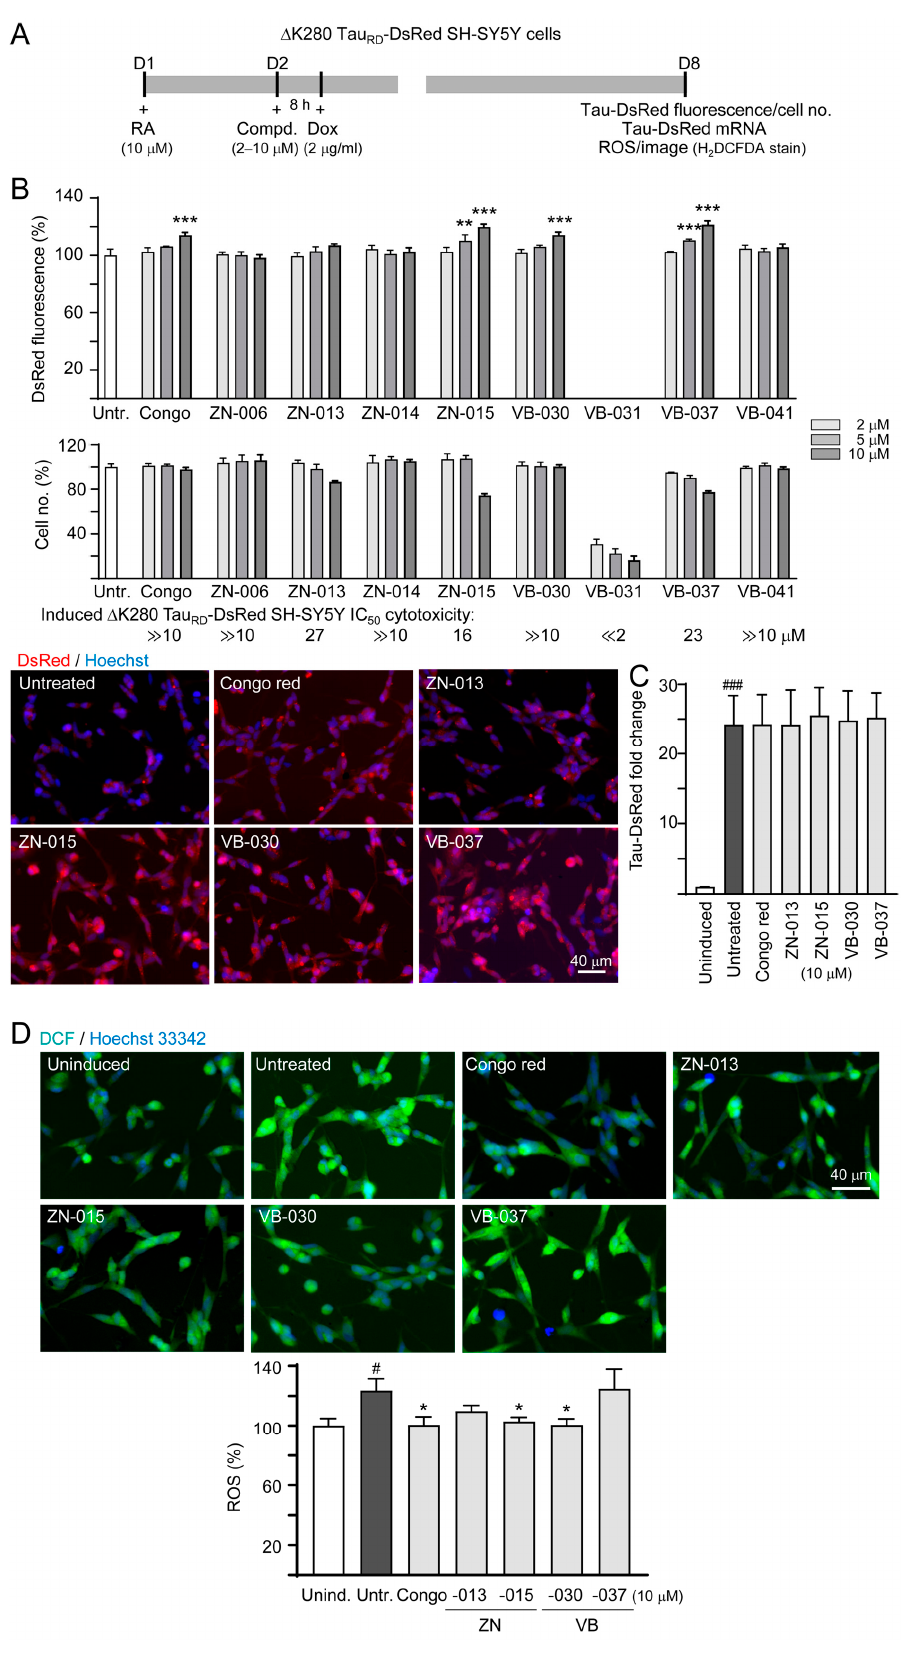
Figure 2. ZN/VB compounds screen using the Tet-On ∆ K280 Tau RD -DsRed SH-SY5Y cell model for AD. ( A ) Experimental flowchart. At day 1, cells were plated in the presence of retinoic acid (RA, 10 µ